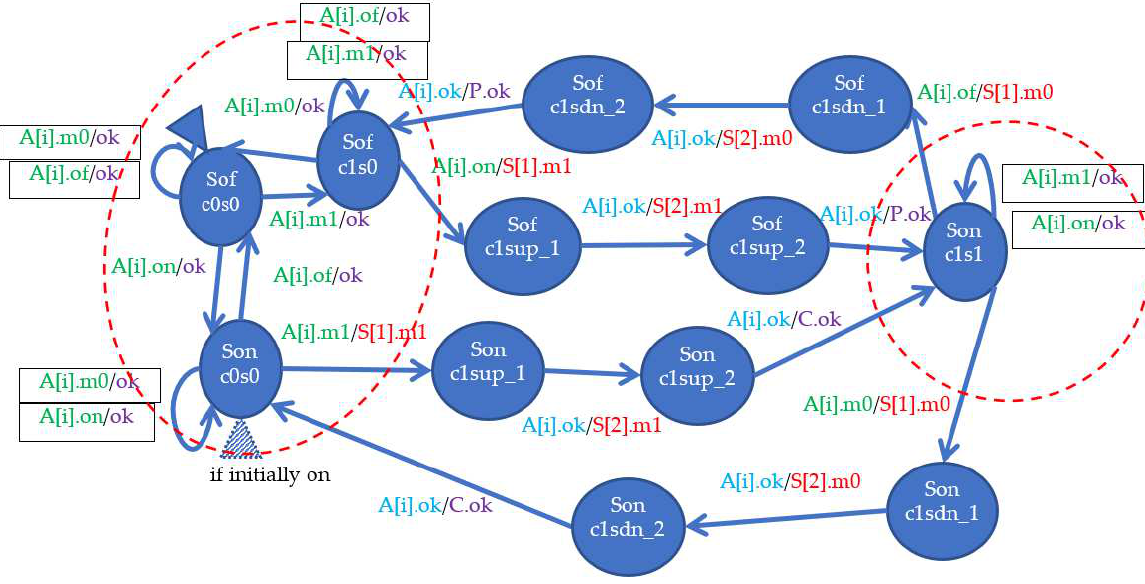
Figure 8. Galvanic connection model.